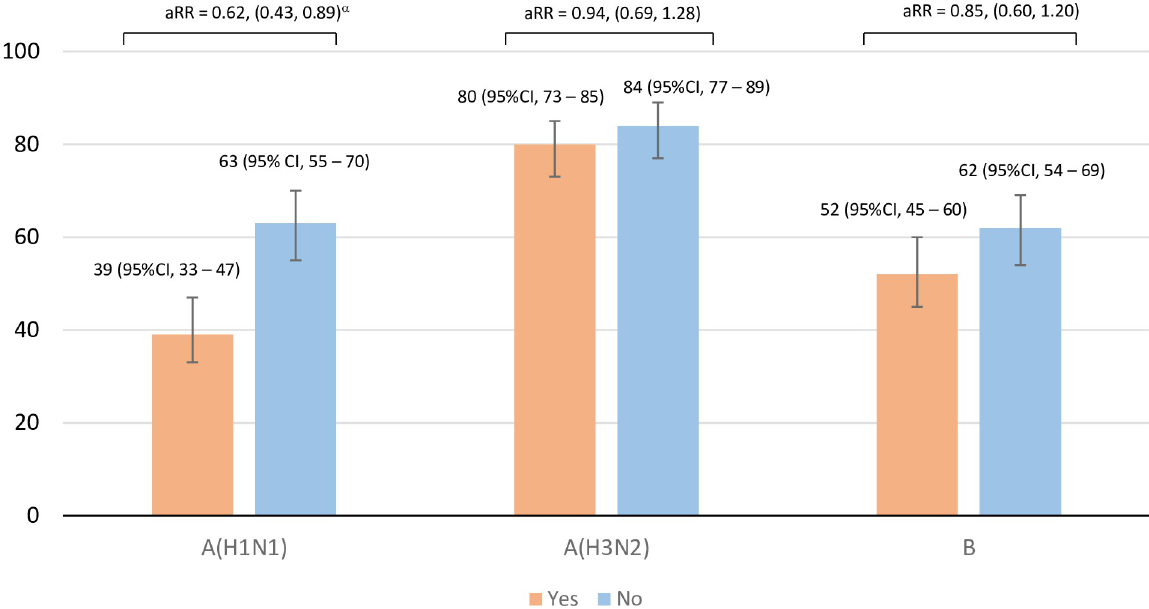
Fig 3. Prevalence of sero-conversion at 1 month among previously vaccinated group (Yes) and previously unvaccinated group (No) of IIV3 in 2014–2015 season. aRR = adjusted relative risk, Log-binomial regression adjusted for age group and sex, CI = confidence interval, α Significance level at <